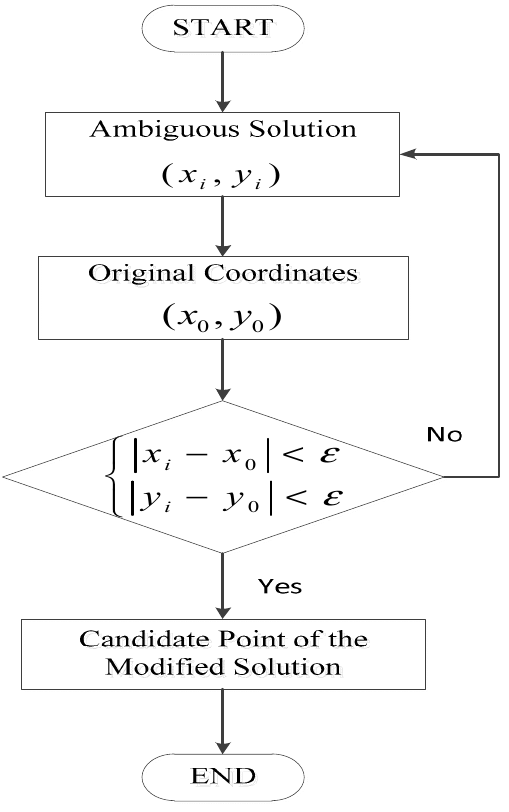
Figure 6. Flow chart of filtering ambiguous solutions.